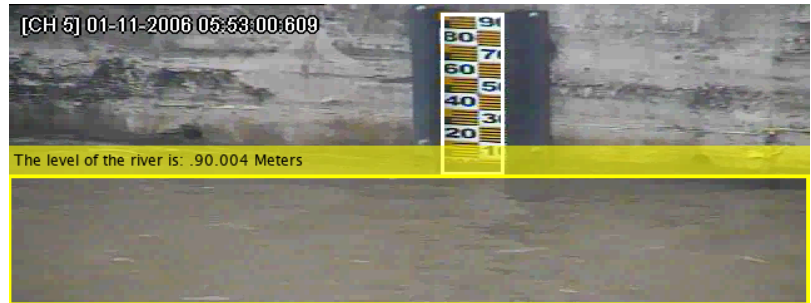
Figure 5. Water level detected in a preprocessed